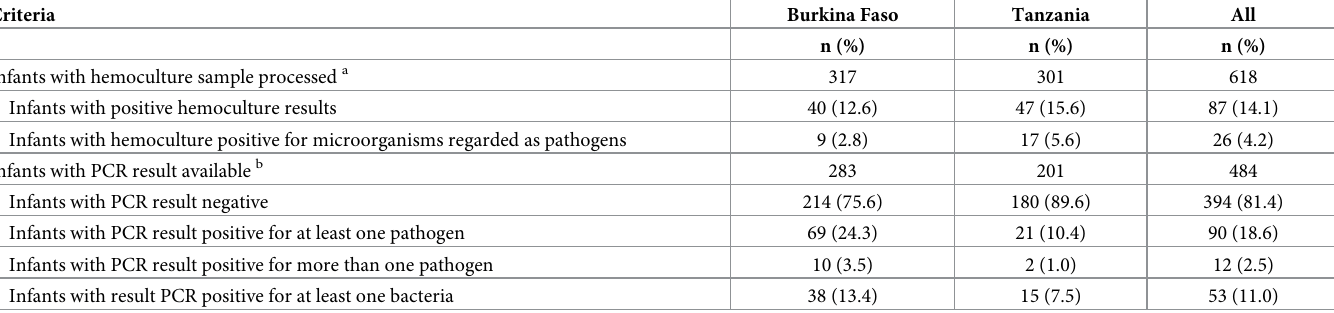
Table 5. Hemoculture results and positivity rate of quantitative polymerase chain reaction (PCR) detection in blood in young infants with clinically suspected inva- sive infection. Criteria